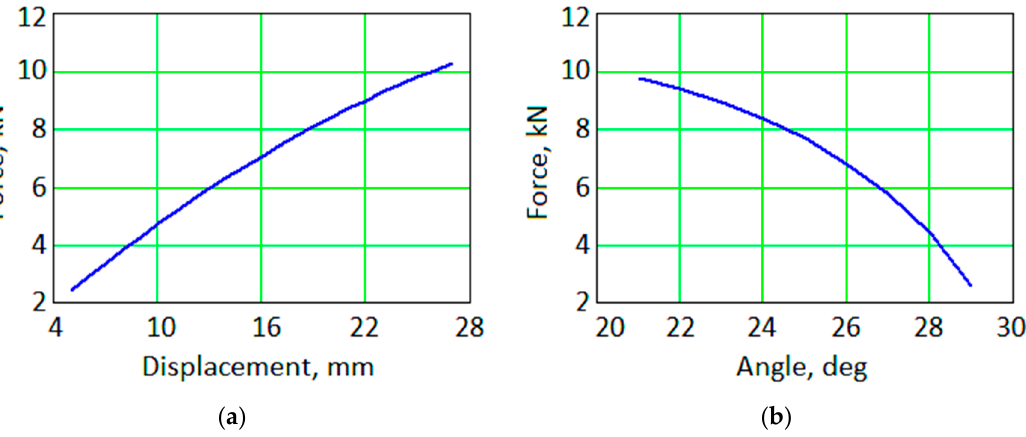
Figure 16. Dependencies of the forces Q [kN] on the displacement S k ( a ) and the angle β [deg] ( b ).